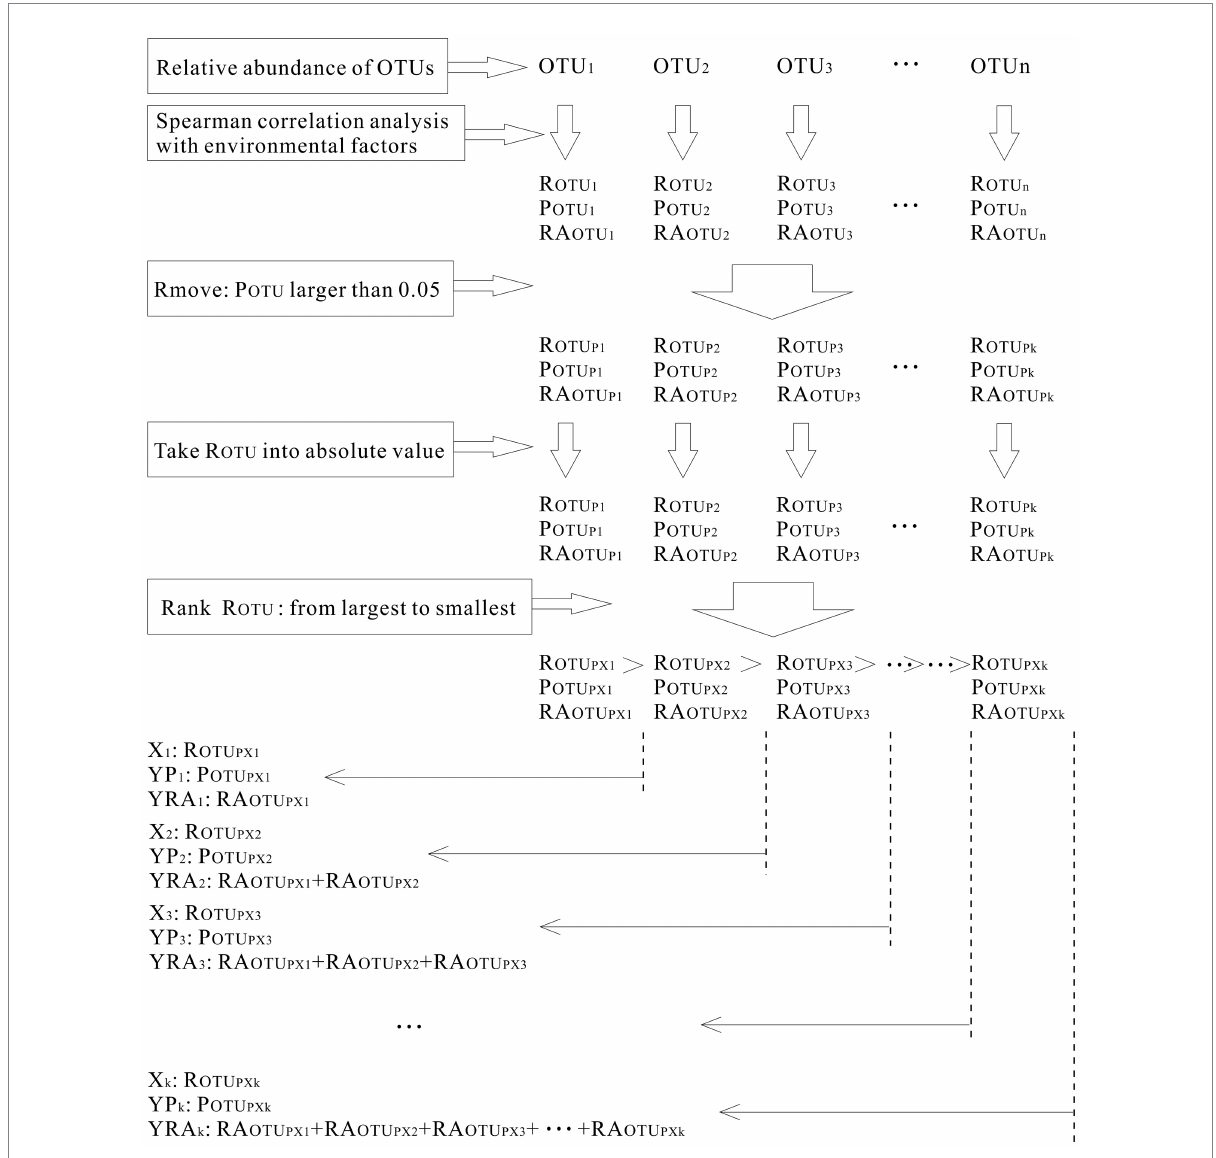
FIGURE 2 Processes of calculating microbial community’s correlation coefficients with environmental